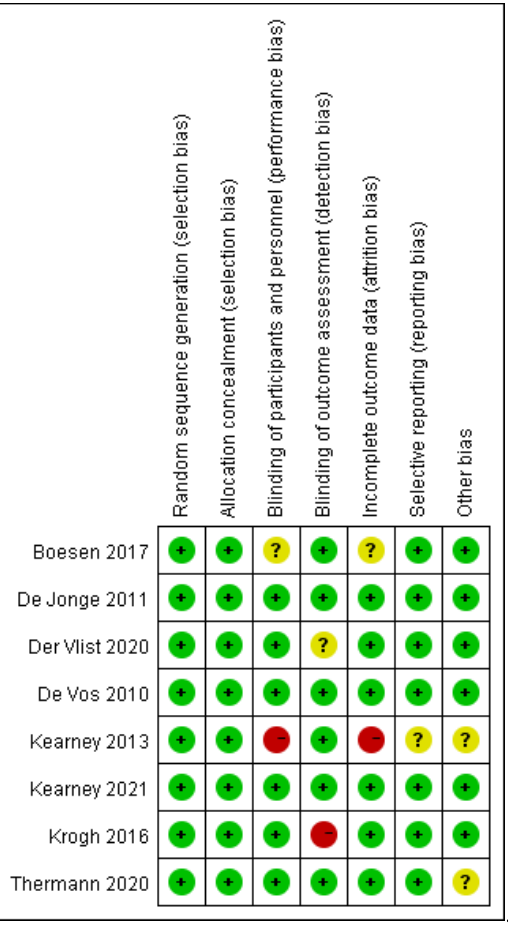
Figure 3. Risk of bias summary diagram: assessment of specific items of bias arising from all included studies.